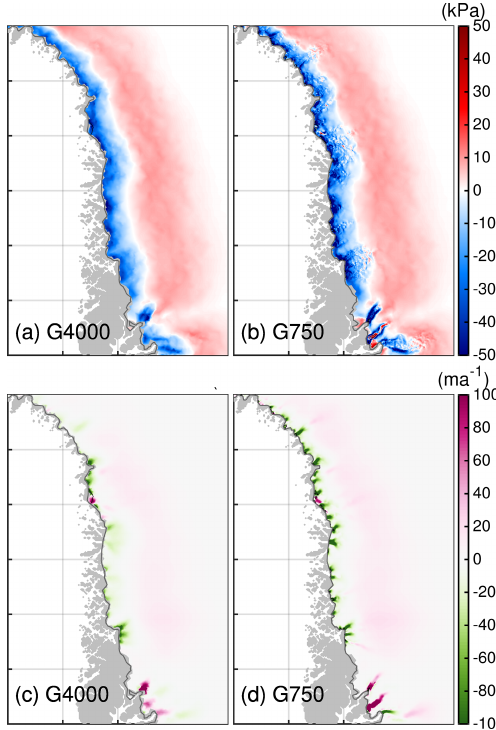
Figure 13. (a, b) Difference in driving stress between 2100 and 2015 for the northwestern region. (c, d) Difference in basal velocity between 2100 and 2015 for the northwestern region. Region sub- sets are shown in Fig. 2. Dark grey line indicates the initial ice ex- tent. Thin black line indicating the grounding line is not visible as it falls together with the calving front. The grey silhouette shows the Greenland land mask from BedMachine